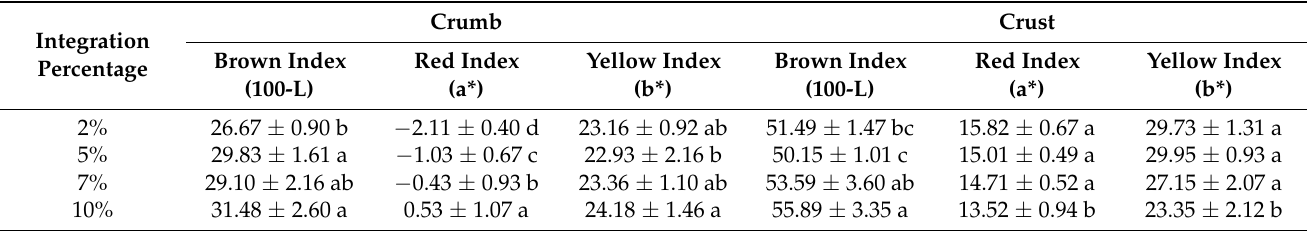
Table 15. Evaluation of colorimetric parameters of the bread samples based on the level of inclusions, as determined by the two-factor ANOVA (analysis of variance) (data are means ± standard